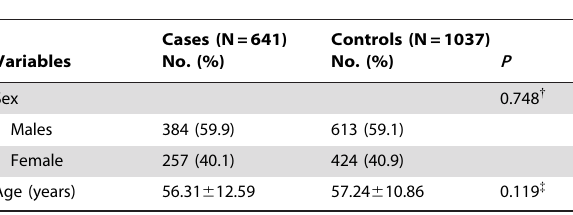
Table 1. The characteristics of the study population.